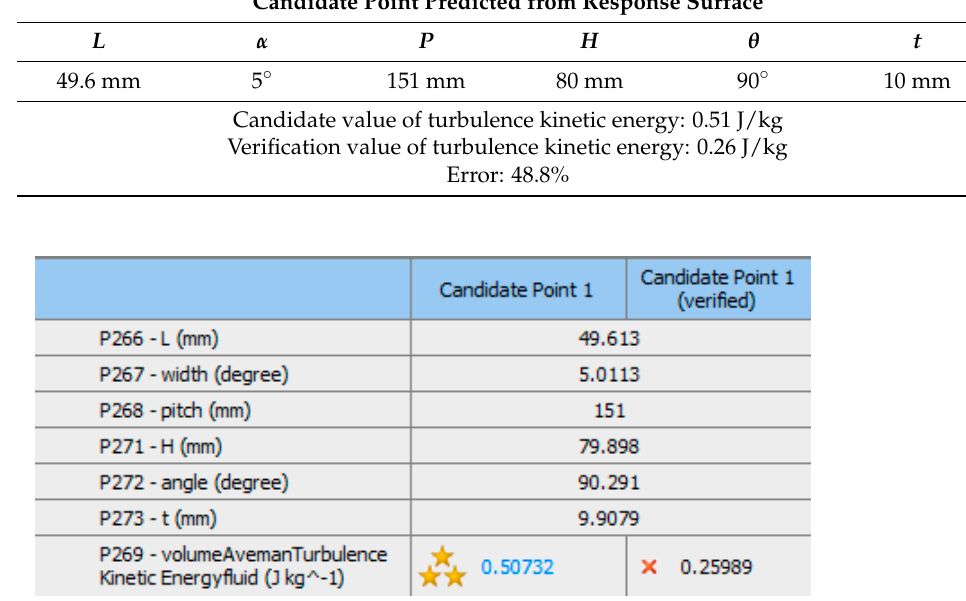
Figure 18. Verification of candidate point recommended from response surface.